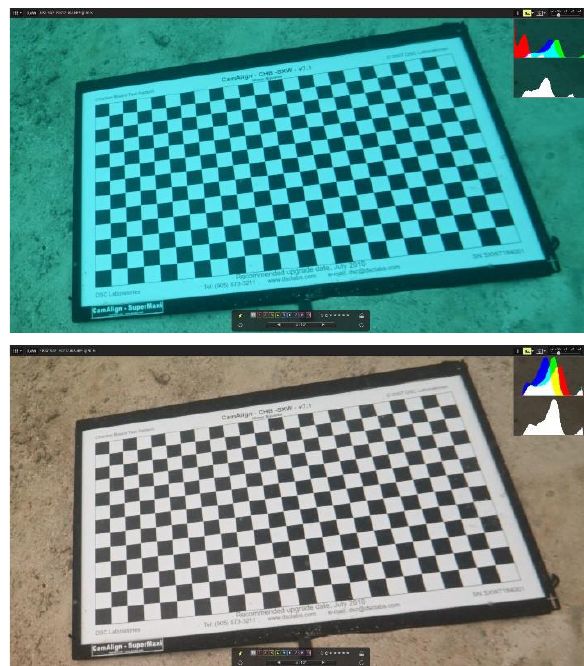
Figure 12. The employed checkerboard test pattern (50 mm squares – CamAlign – CHB – SXW – V7.1) before (top) and after (bottom) the white balancing. The RGB and the luminance histograms are showed on the top right corner both before and after the correction.